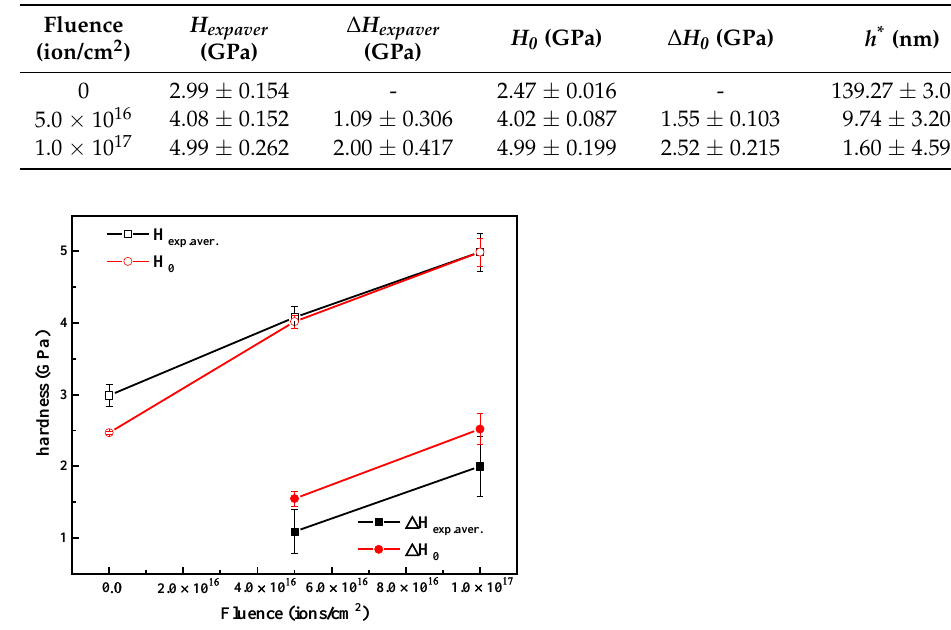
Figure 9. The change of H 0 , H exp.aver. , ∆ H 0 , ∆ H exp.aver . with irradiation Figure 9. the change of H 0 , H exp.aver. , ∆ H 0 , ∆ H exp.aver . with irradiation fluences.